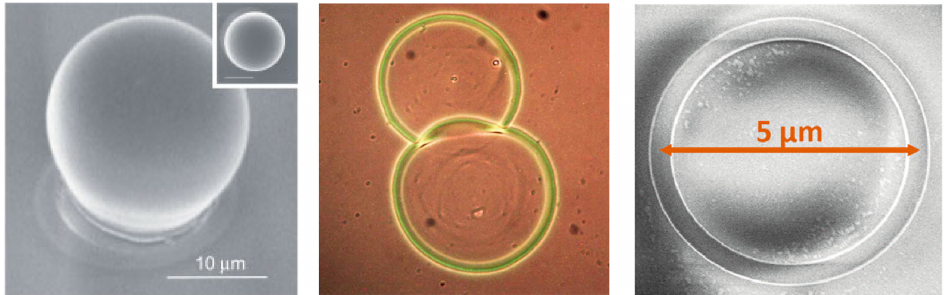
Figure 7. Left : SEM image of a 20 µ m diameter silica microsphere coated by a CdSe/CdZnS titania film. Reproduced with permission from [67]. WILEY-VCH Verlag GmbH & Co. KGaA, 2005. Center : Microscope image of a coffee ring microresonator. Reproduced with permission from [69]. The Royal Society of Chemistry, 2010. Right : SEM image of a template stripped microring. Reprinted from [73]. American Chemical Society, 2018.